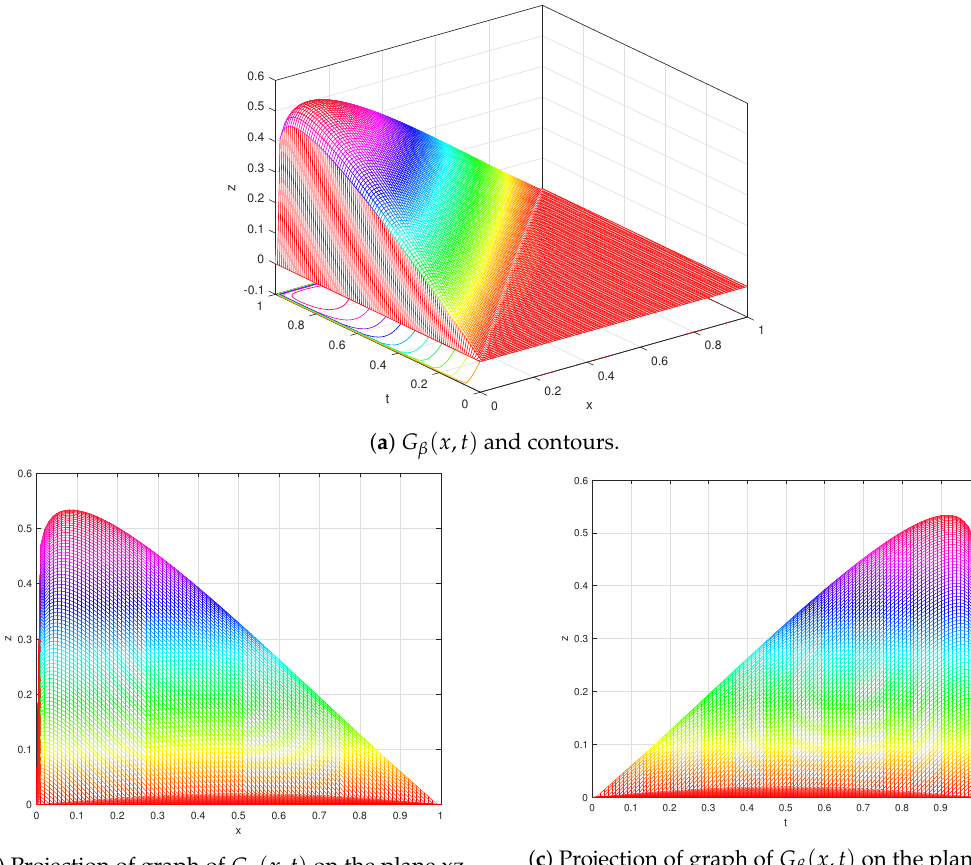
( c ) Projection of graph of G β ( x , t ) on the plane tz. Figure 1. The Green function for β =